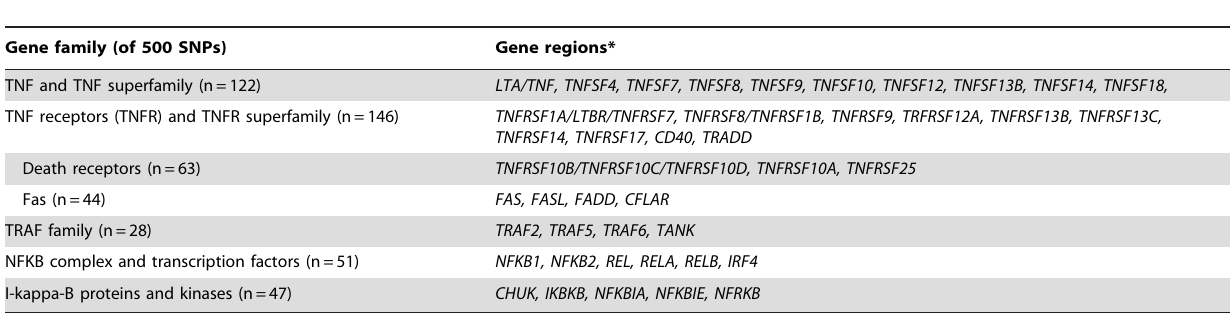
Table 1. Gene families and regions of analyzed candidate genes in three independent NHL case-control studies.